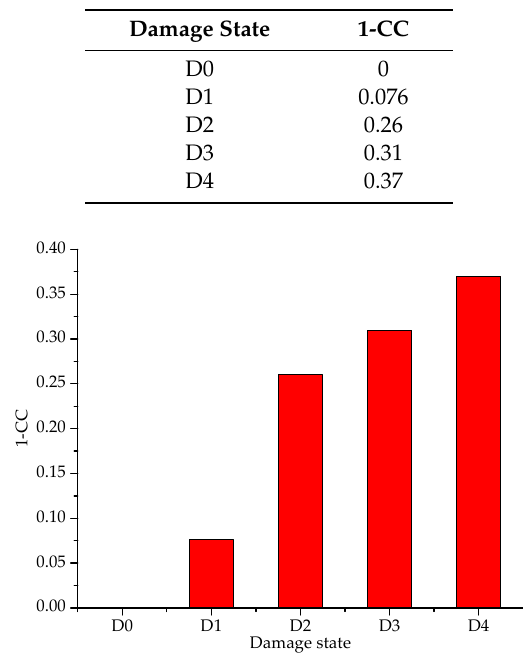
Table 1. Damage index: 1-CC at PZT-1.